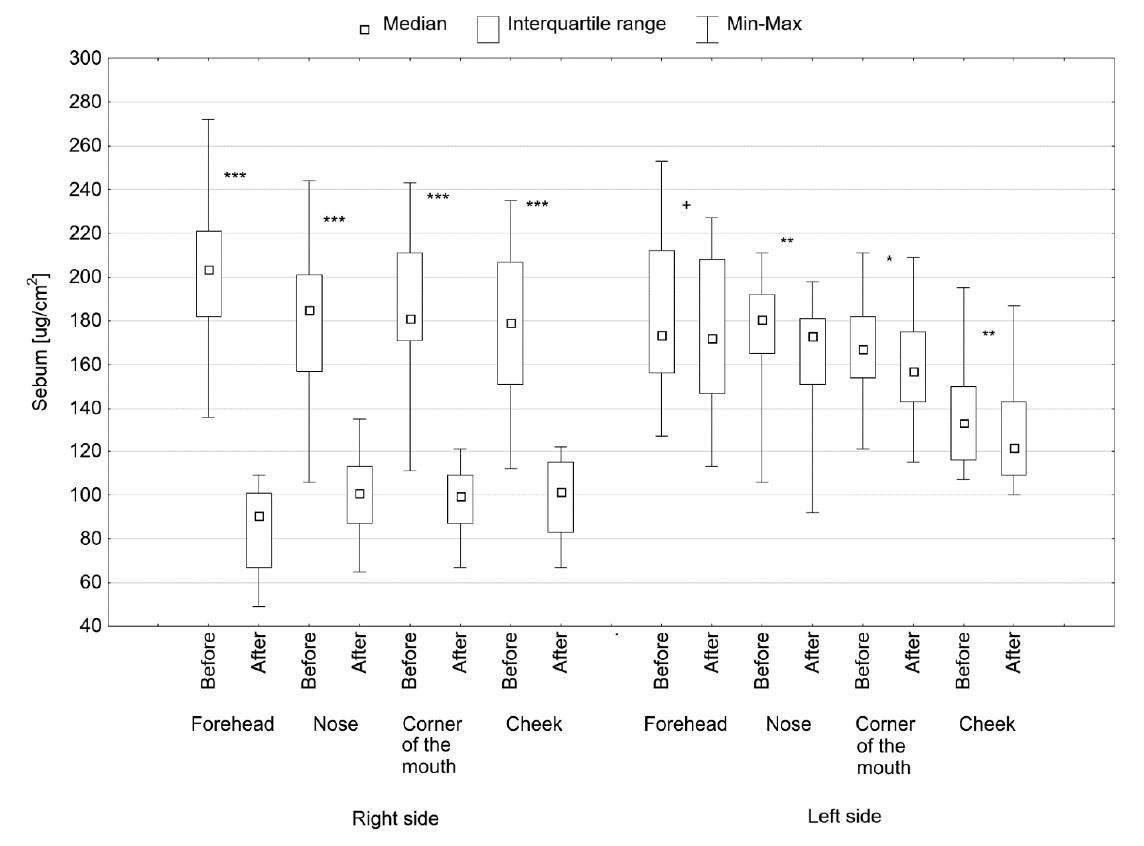
Figure 2. Sebum value in various areas of the face on the right side, treated with microdermabrasion and pyruvic acid, and on the left side, treated only with acid before and after treatments, + p = 0.055, * p < 0.05, ** p < 0.01, *** p < 0.001.